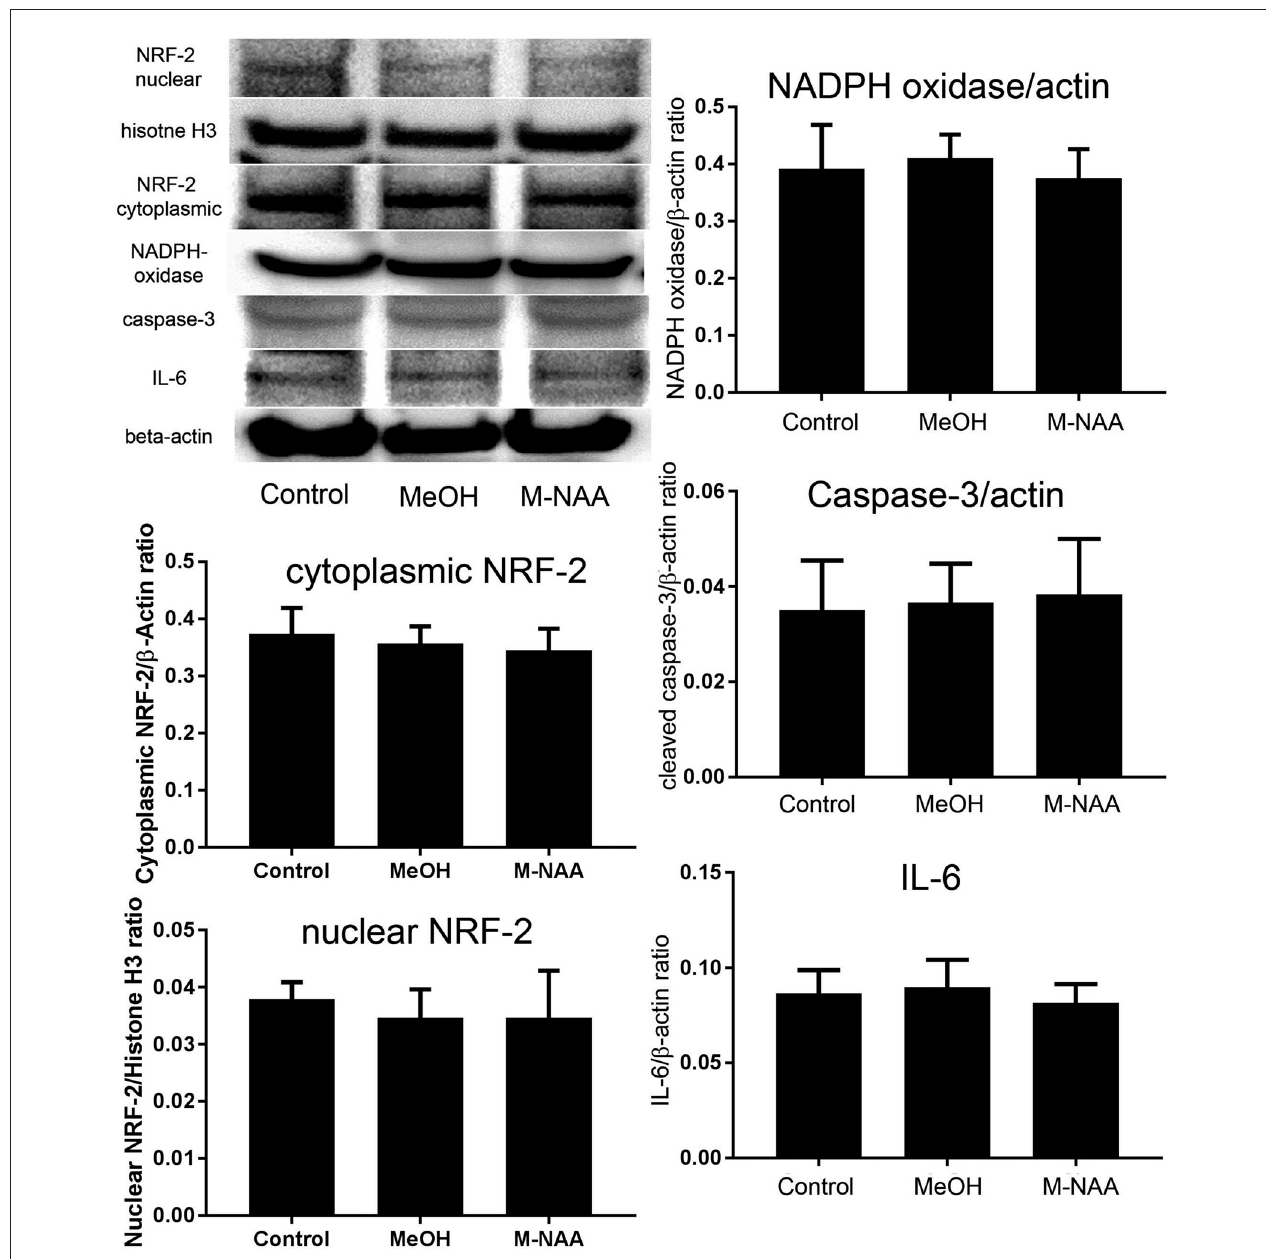
FIGURE 3 | Western blot analyses of inflammation markers. Western blots were used to assess expression levels of several markers of inflammation and stress responses including interleukin-6, cleaved caspase-3 and NADPH oxidase. No significant differences were observed among the groups. We also evaluated expression of the cytoprotective transcription factor nuclear factor (erythroid-derived 2)-like 2 (NRF-2) in both cytoplasmic and nuclear fractions and no translocation of NRF-2 to the nucleus was observed. Values indicate means ± SD with n = 6 per